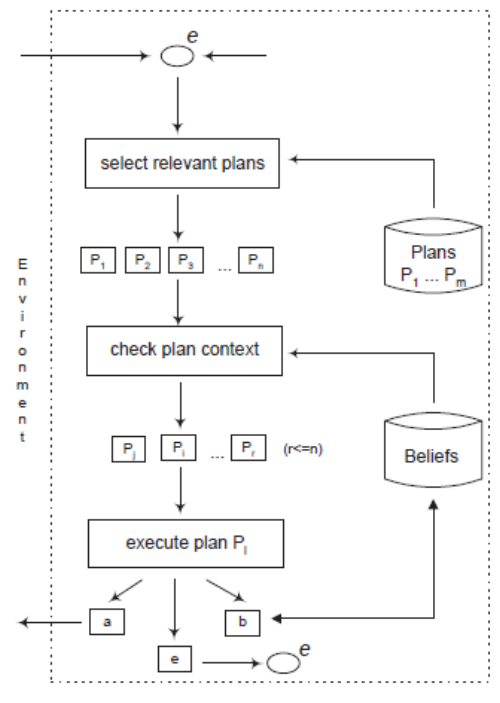
Figure 1. Reasoning cycle used by a BDI